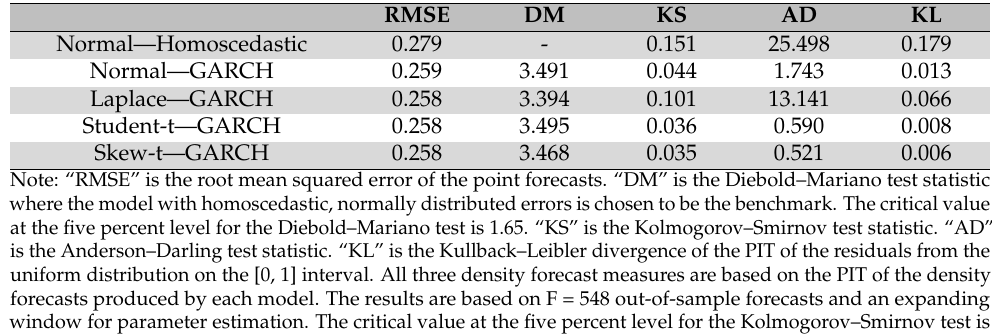
Table 4. Forecast evaluation